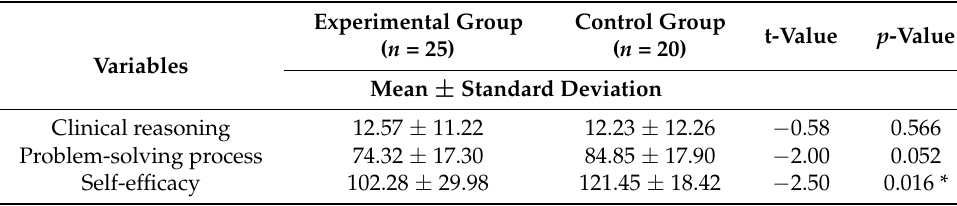
Table 3. Homogeneity for dependent variables of subjects between experimental and control groups ( n = 45).